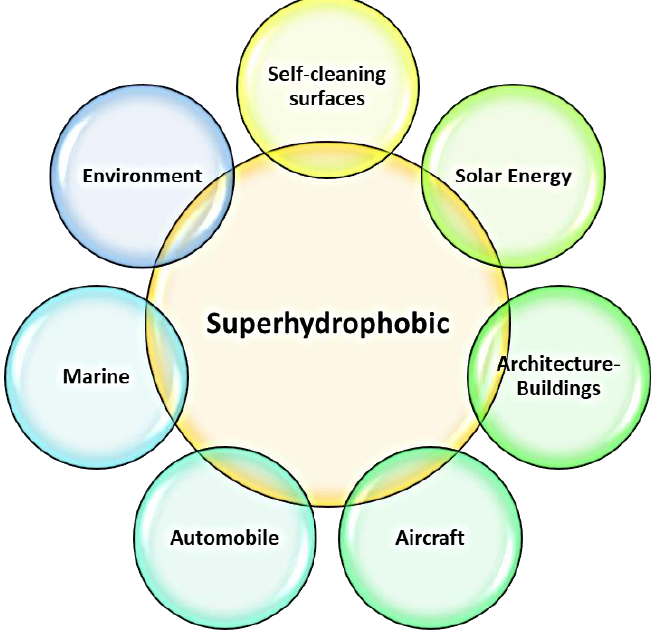
Figure 4. Applications of superhydrophobic surfaces.